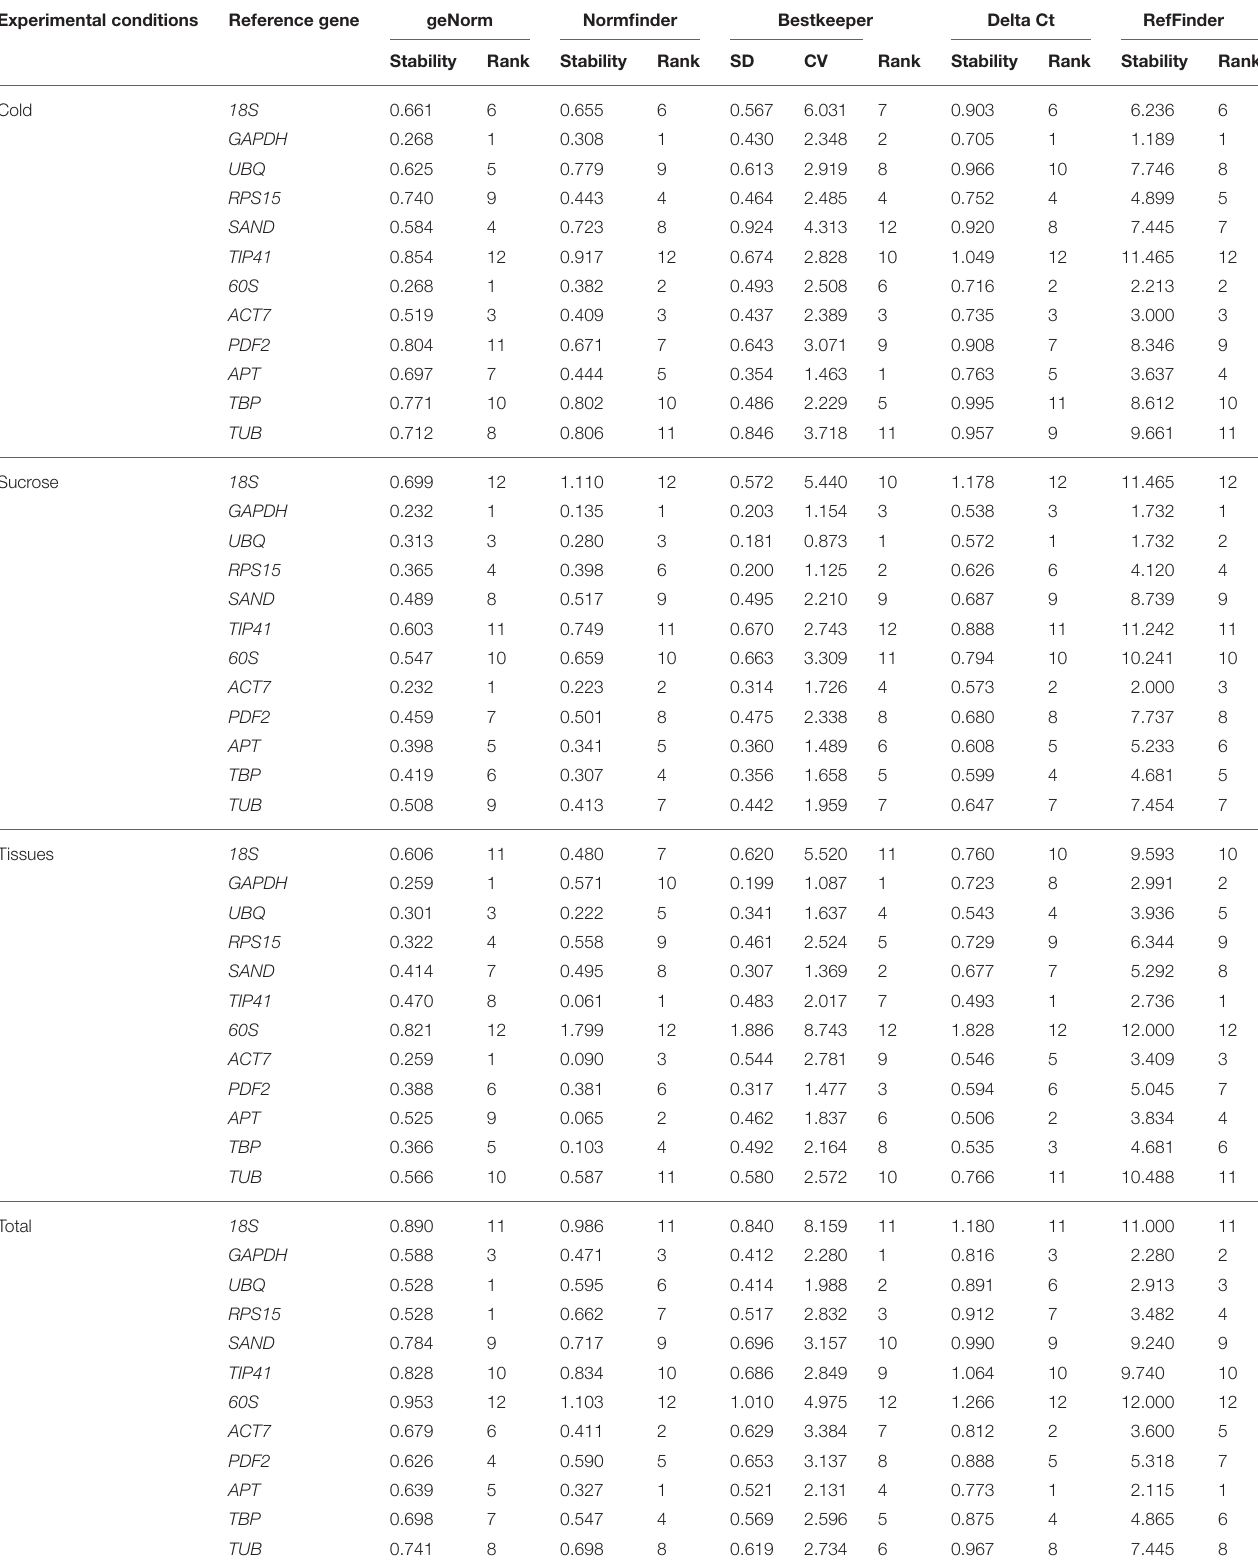
TABLE 2 | Stability of reference gene expression in each subset. Experimental